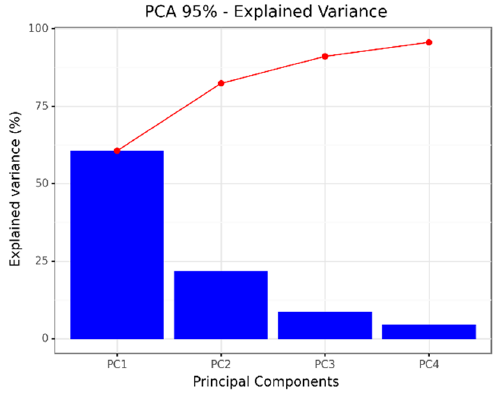
Figure 8. PCA explained variance plot.